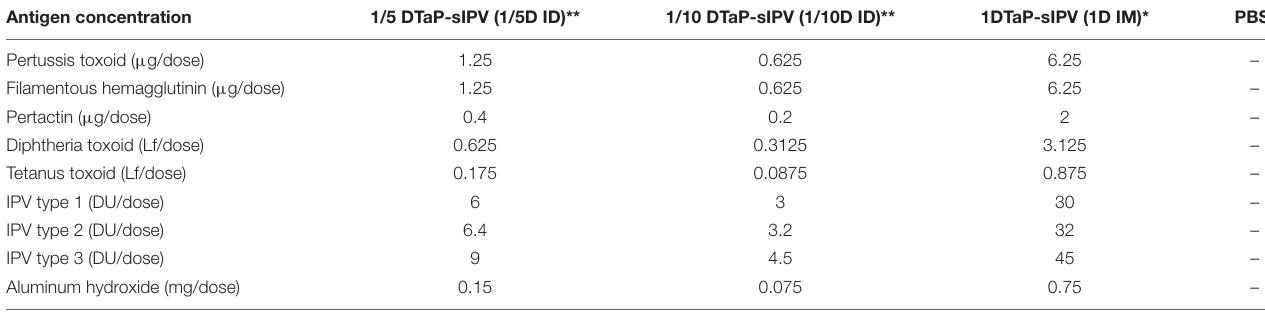
TABLE 1 | Composition of experimental and reference vaccines used in the